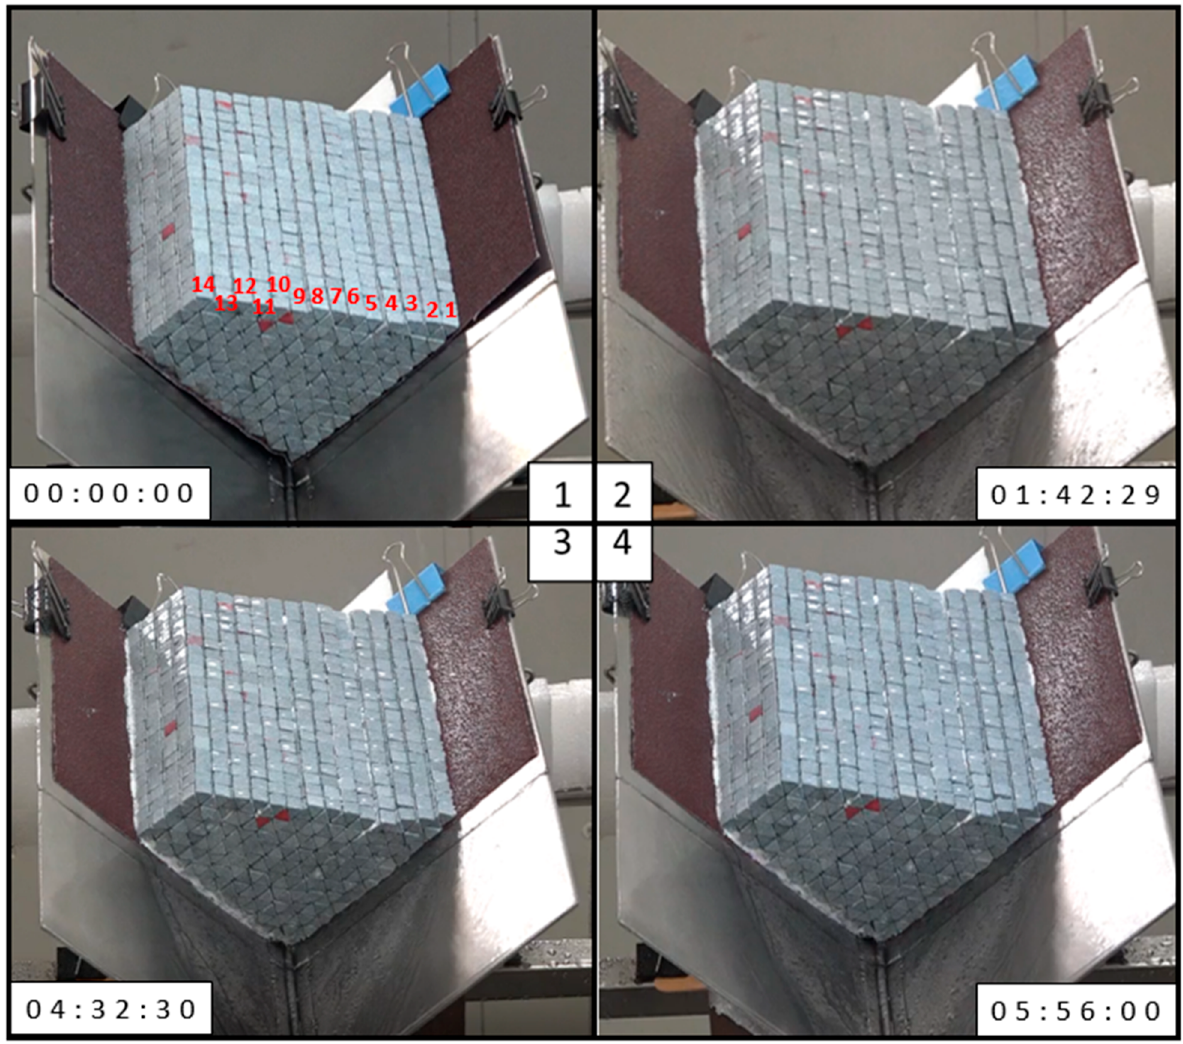
Figure 7. Physical Model B ( i a = 40° and ω 1 = ω 2 = 45°).